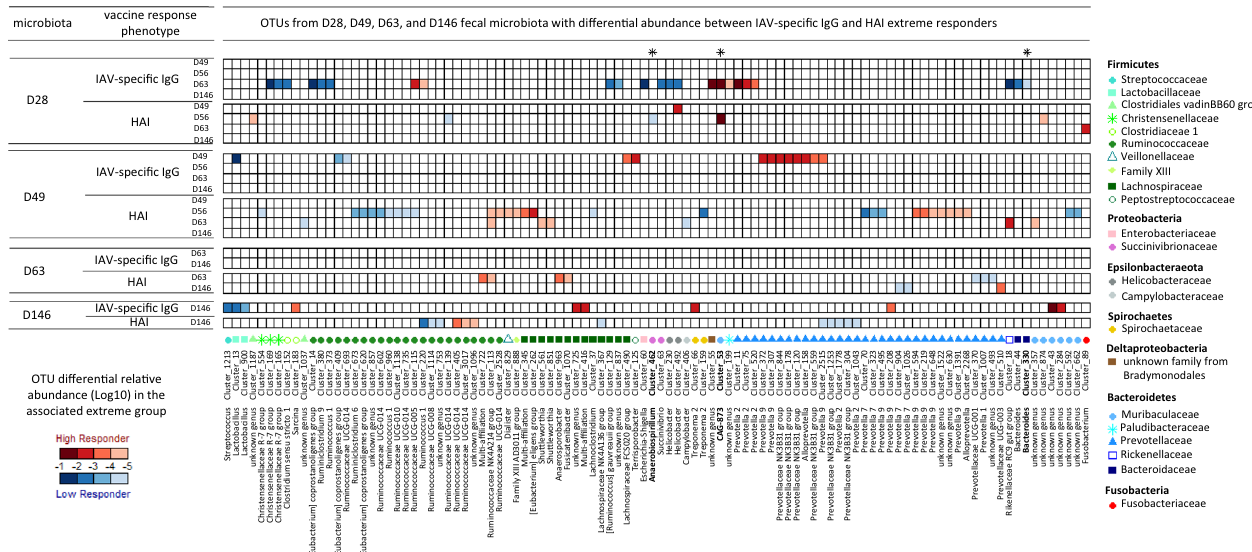
Fig. 8 Representation of the 102 OTUs identi fi ed as differentially abundant in the fecal microbiota of 28, 49, 63, and 146-day-old pigs between groups of high and low responders for IAV-speci fi c IgG and HAI at all time points post-vaccination. The mean OTU relative abundance per group is represented with a color gradient. OTUs that were more abundant within the high responder groups are represented with a red gradient, and OTUs that were more abundant within low responder groups are represented with a blue gradient. Asterisks highlight the three OTUs that were also identi fi ed by sPLS-DA as predictors of vaccine response at the same time point for the same vaccine phenotype. Taxonomic annotation is given at the genus level. All corresponding data are available in Supplementary Table 3 and in Supplementary Data